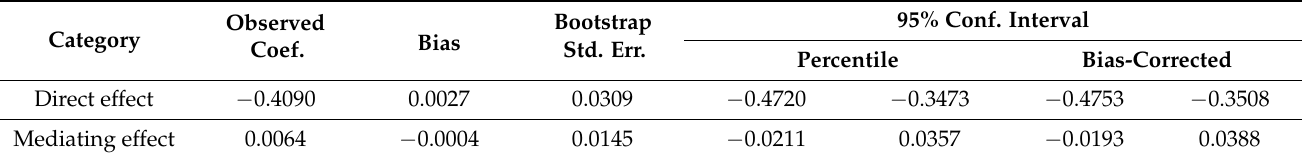
Table 6. Mediation analysis of adaptability between CRHW and physical capital: bootstrap